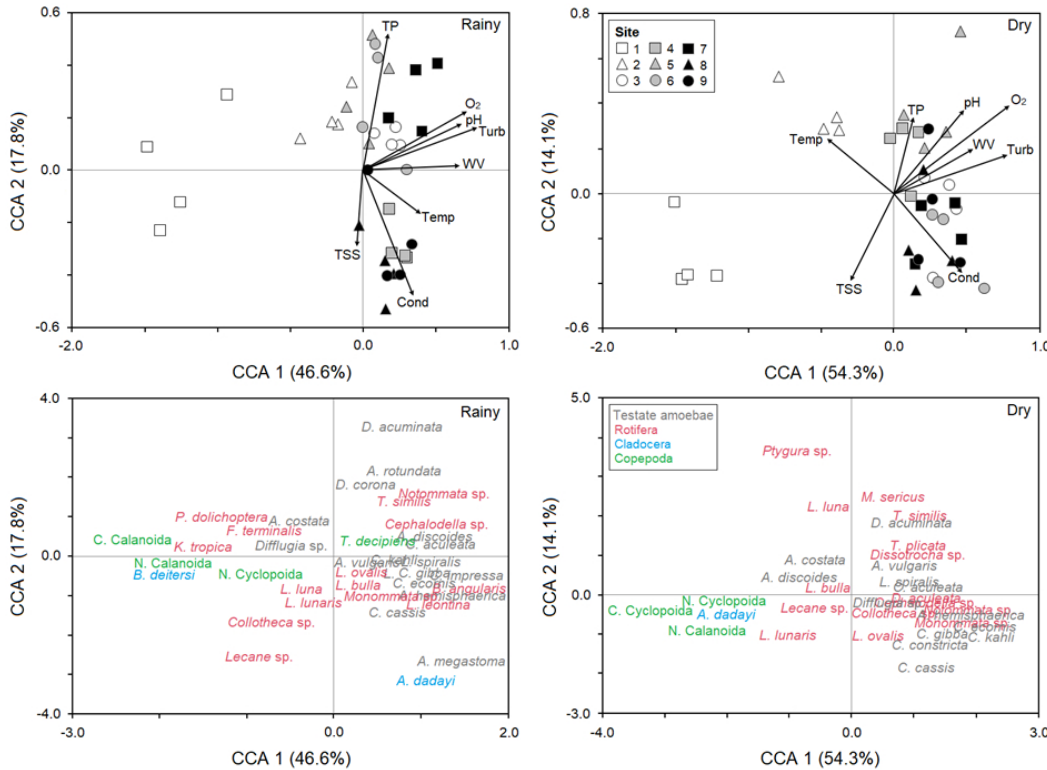
Figure 7. Canonical correspondence analysis (CCA) ordination showing the relationships between the environmental variables and the environments, and zooplankton taxa of the Aporé River, Paranaíba River basin, during the different hydrological seasons. Abbreviations: Cond, electrical conductivity; O , dissolved oxygen; Temp, temperature; TP, 2 total phosphorus; TSS, total suspended solids; Turb, turbidity; WV, water flow